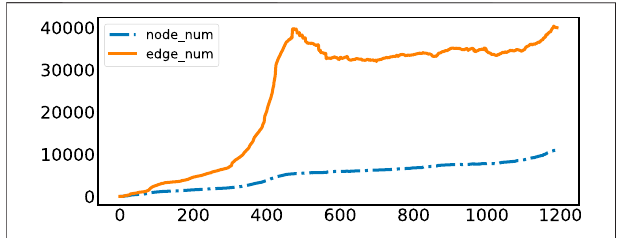
FIGURE 3 | Lightning network nodes and edges growing with